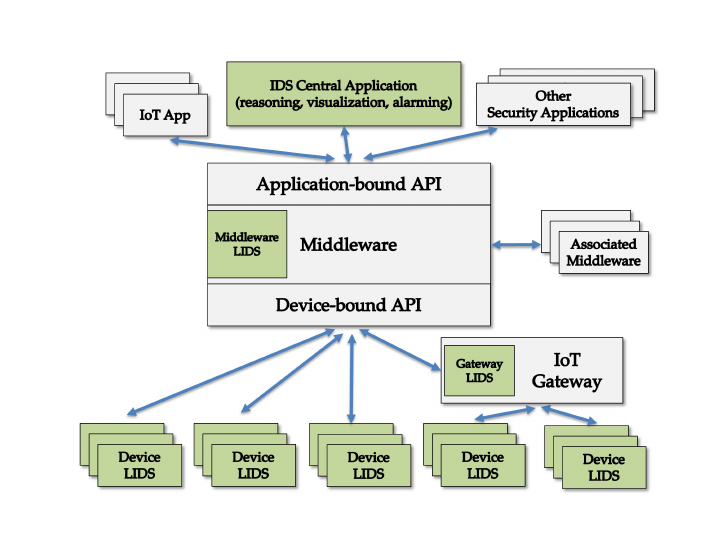
Figure 10. A fully distributed IDS for